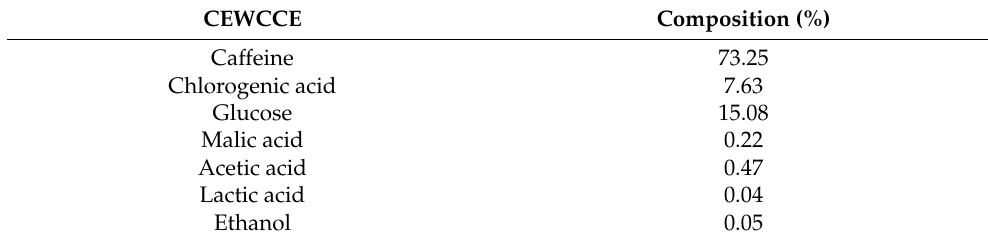
Table 2. 1 H qNMR–compositional analysis of